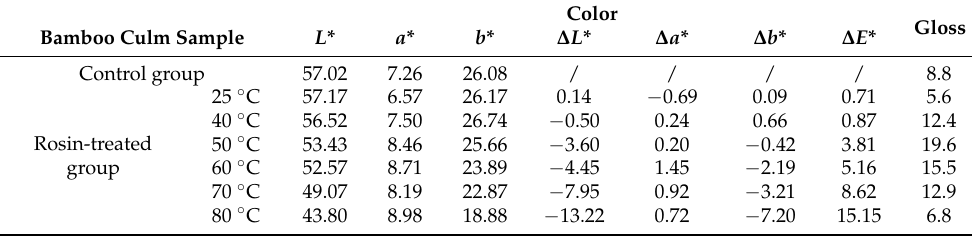
Table 1. Change in color and gloss of bamboo culm after rosin treatment with different temperature.